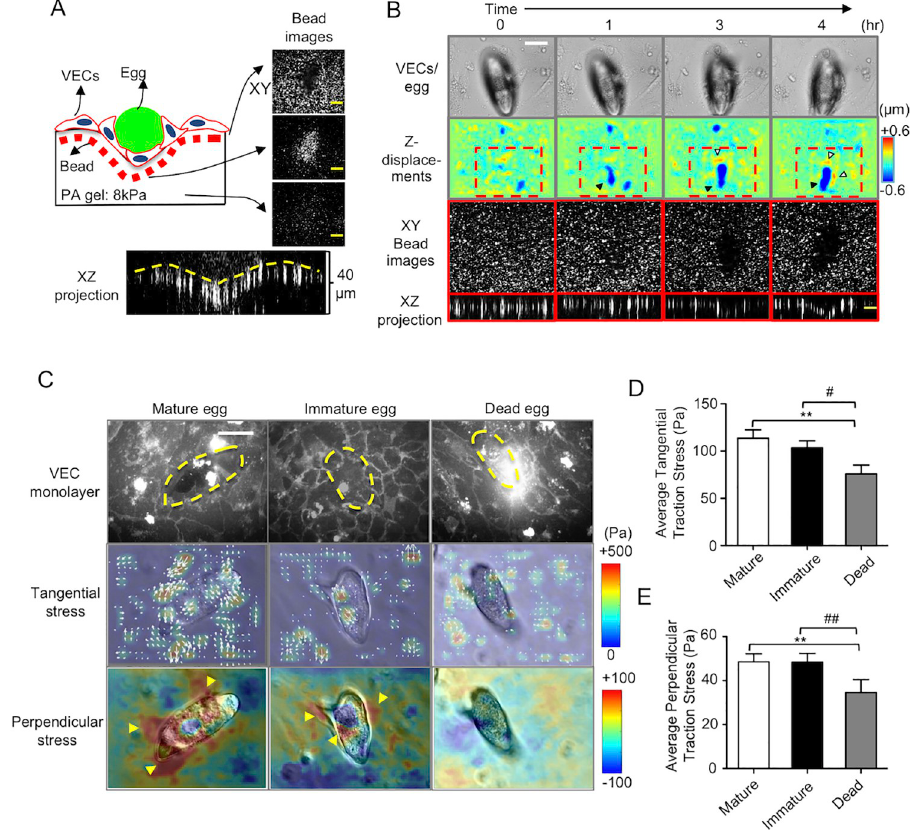
Fig 5. 3D traction forces exerted by VECs during encapsulation of S . mansoni eggs. (A) Schematic of the 3D confocal microscopy setup to measure the 3D deformation of VECs during encapsulation. Fluorescent beads (red) were embedded in the elastic FN-coated elastic hydrogel substrates on which the VECs and eggs (green) were co- cultured. Orthogonal (xy and xz) views of the beads’ fluorescent channel demonstrate the 3D substrate deformation underneath the eggs (scale bar: 10 μ m). (B) Temporal evolution of substrate deformation during encapsulation of a live mature egg. The top row shows bright-field images of the egg and VECs (scale bar: 50 μ m). The second row shows maps of the z-displacement (perpendicular to the substrate) in the same field of view. Downward pushing patterns (negative z-displacement) are indicated by black arrowheads whereas upward pulling patterns (positive z- displacement) are indicated by white arrowheads. The third and fourth rows, respectively, show xy and xz enlarged images of beads in those areas with the greatest deformation (scale bar: 10 μ m) as delimited by the red dashed-line box in the second row. (C) 3D traction stresses exerted by VECs interacting with live mature, live immature and dead eggs after 4 h. The top row shows VEC cell membrane staining (scale bar: 50 μ m). The yellow dashed line shows the egg location. The second row shows the in-plane tangential (xy) stress magnitude (represented by the color map) and direction (white arrows). The third row shows the perpendicular (xz) stress magnitude. Positive/negative values indicate upward pulling and downward pushing, respectively. Note the downward pushing forces (blue color) localized at the egg anchoring site which is surrounded by upward pulling forces (red color, also indicated by yellow arrowheads). (D-E) Quantification of tangential (D) and perpendicular (E) traction stress magnitudes. Data are presented as the mean ± s.e.m. �� indicates p < 0.01, and # and ## indicate p < 0.05 and p < 0.01, respectively, using one-way ANOVA with Turkey’s post-test. For mature, immature and dead eggs, 26, 20 and 12 eggs were used, respectively, across three independent experiments.